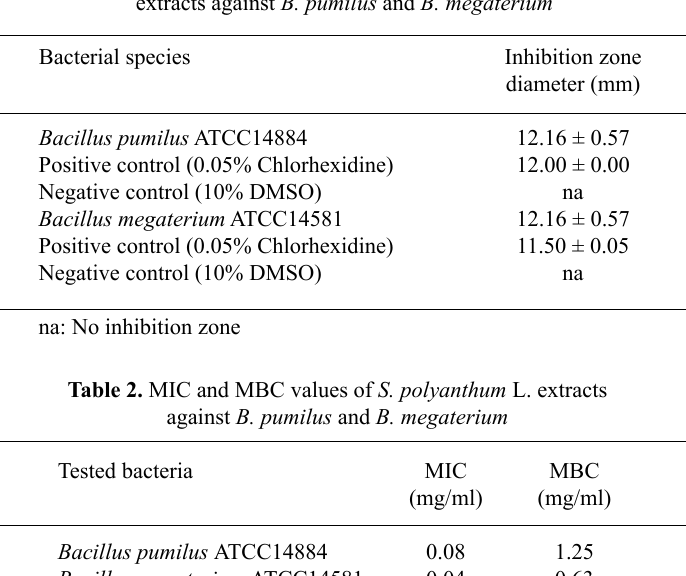
table 1. Inhibition zone diameter of S. polyanthum L.